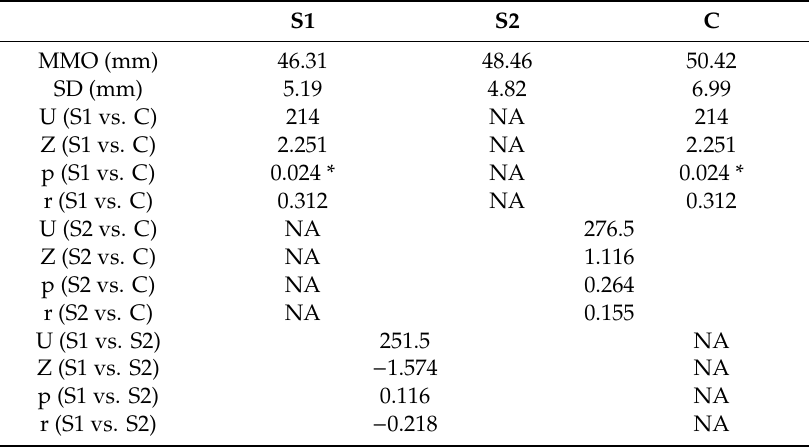
Table 1. Comparing means of active maximal mouth opening